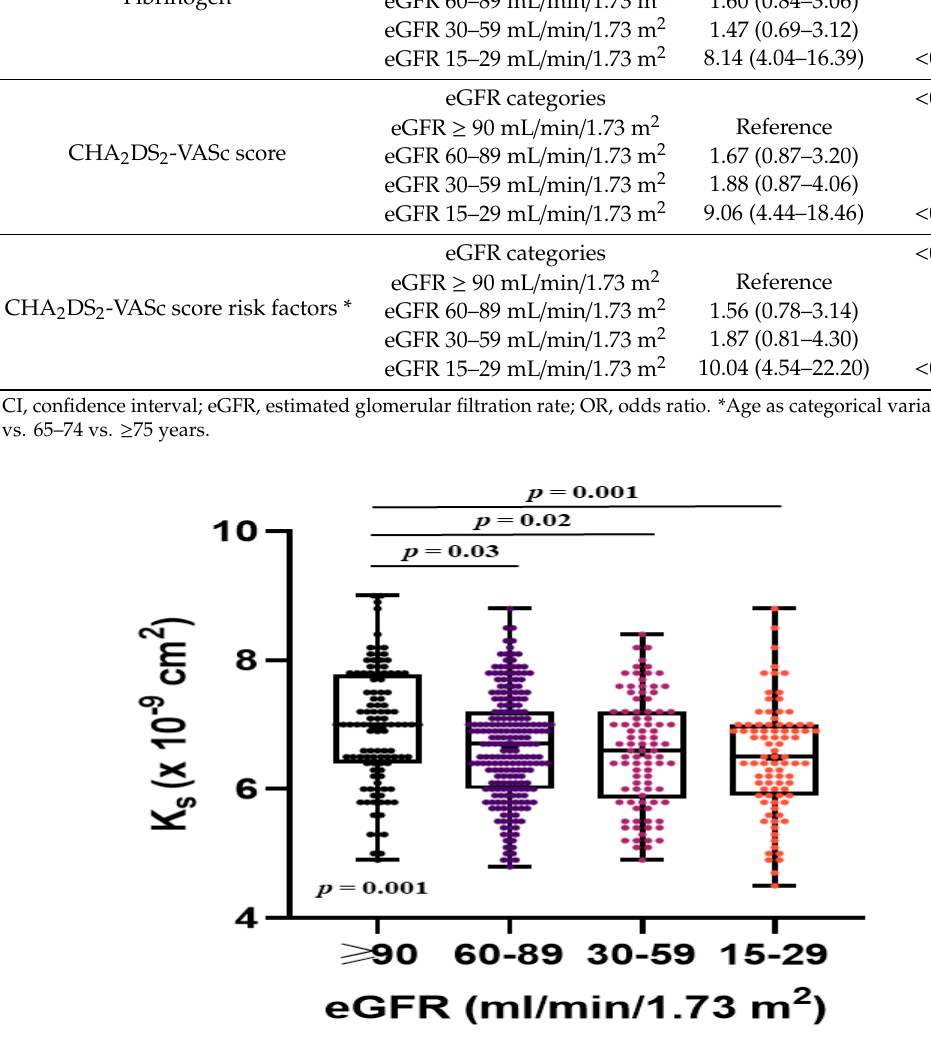
Figure 2. Associations between fibrin clot permeability (K s ) and estimated glomerular filtration rate (eGFR) categories in patients with atrial fibrillation. Data are shown as medians (interquartile ranges), maximum and minimum values. Mean values are presented as the plus signs.